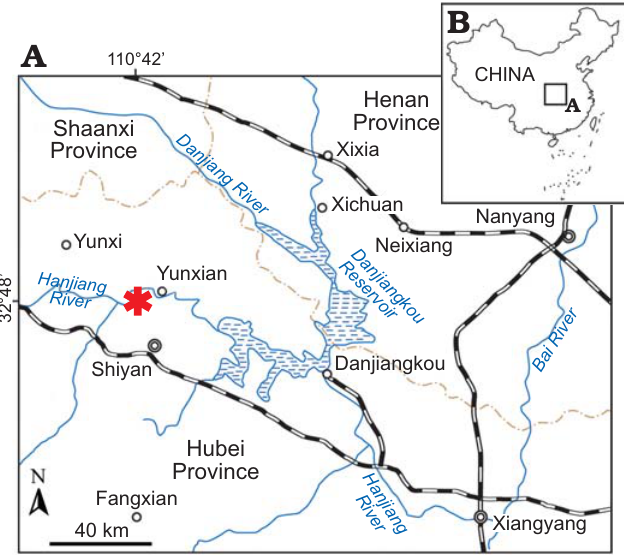
Fig. 1. A , B . Map of the location of dendroolithid eggs (asterisk) in Yun- xian, Hubei Province,